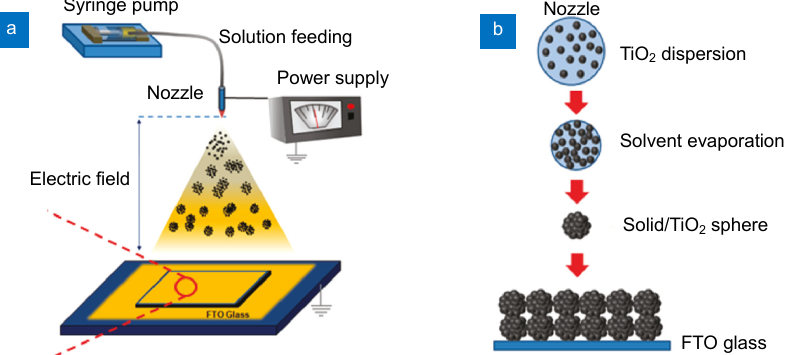
Fig. 11 | Schematic diagram of (a) electrostatic spray and (b) formation of hierarchically structured TiO 2 nanospheres 100 .